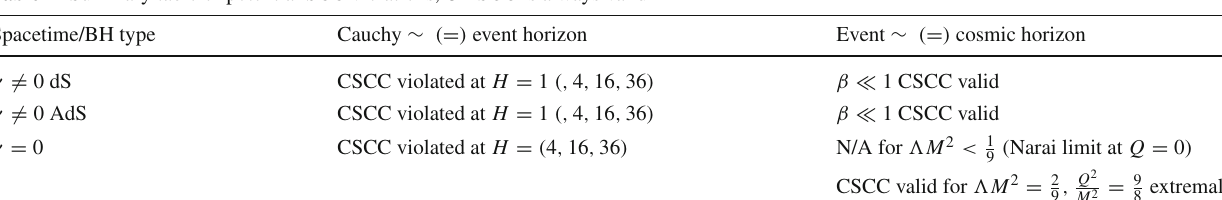
horizon and thus are not subject to the β criteria. CSCC should be protected by mass inflation [60] for the extremal RN BH case